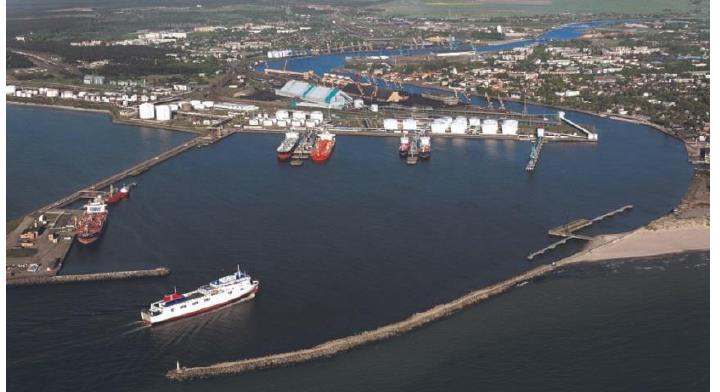
Figure 5. Port of Ventspils. Source: [70].